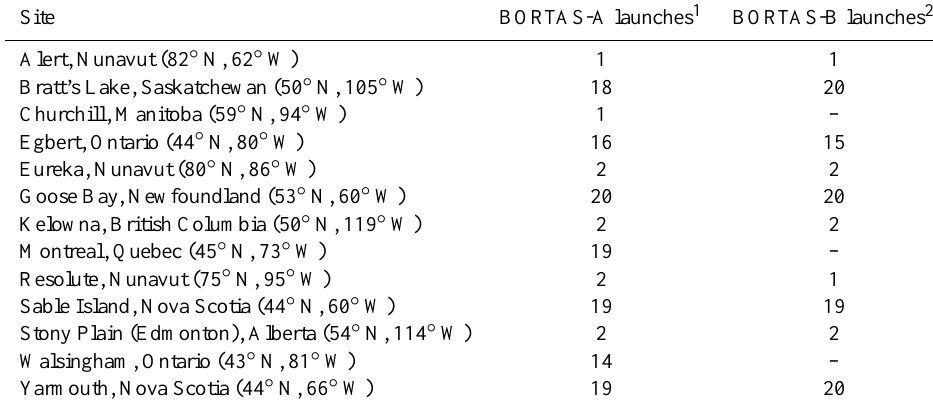
Table 3. Environment Canada ozonesonde launch sites during BORTAS phases A (2010) and B